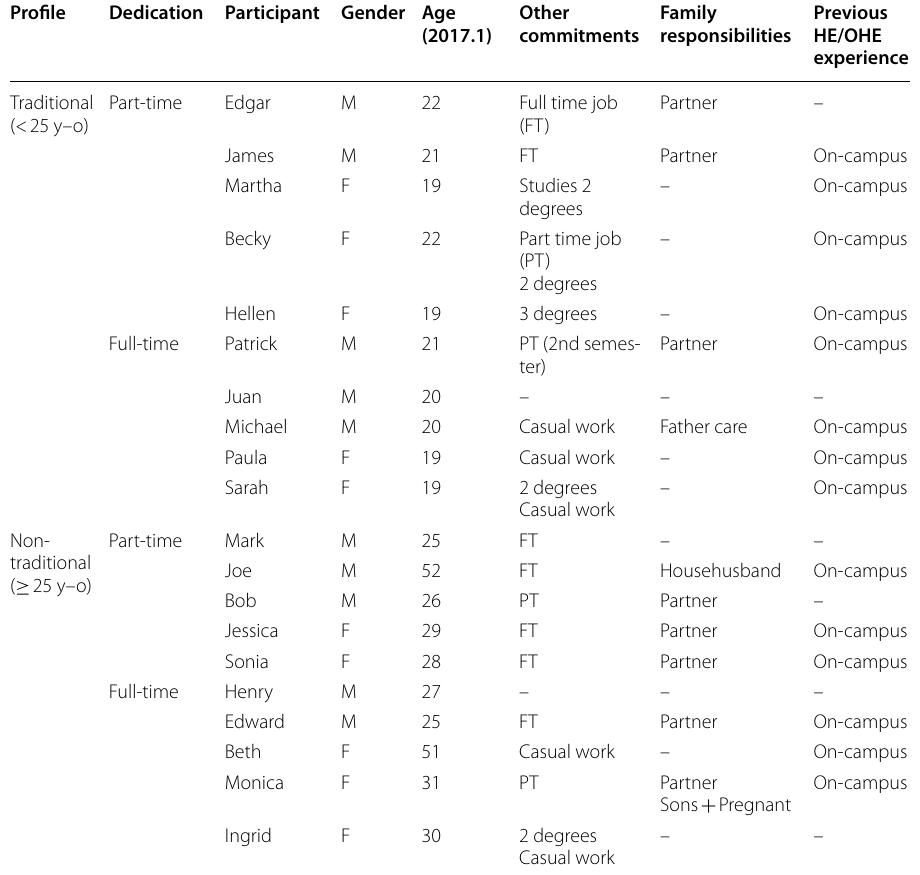
Table 1 Participants